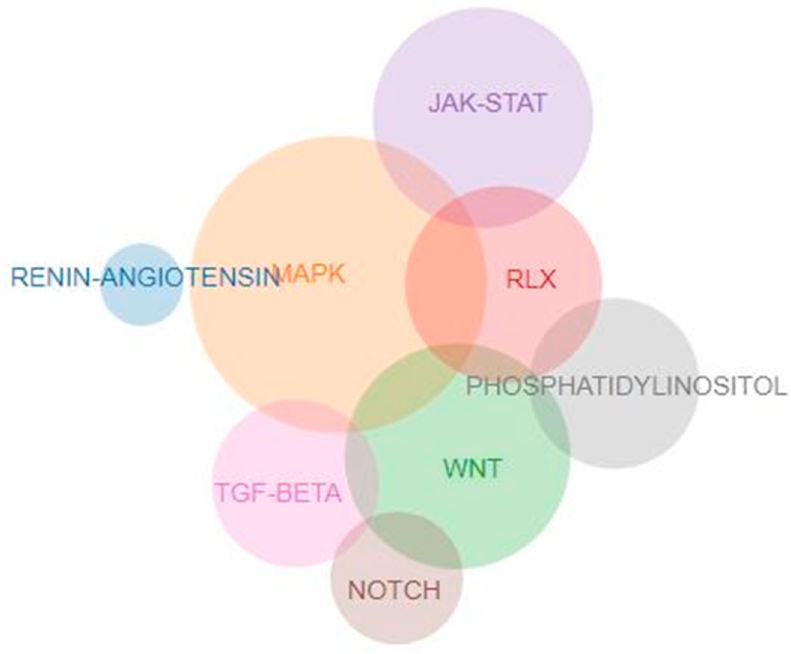
Figure 1. Venn diagram showing the overlap between genes in pathways.